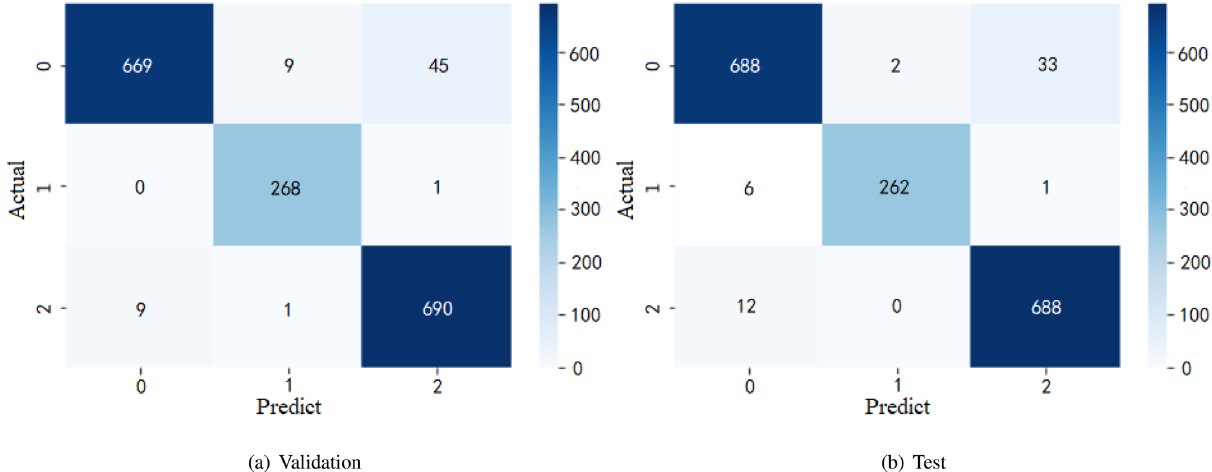
Figure 9. Confusion matrix for three-class classification on X-ray dataset: (Classes: 0—COVID, 1—Pneumonia and